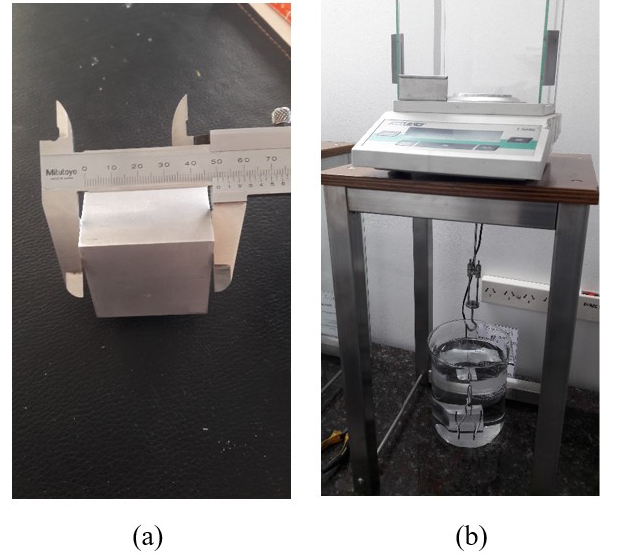
Figure 1. Experimental determination to 0.1% of the mass of an aluminium cube following the new definition of the kilogram trace- able to the Planck constant. The cube volume is obtained by di- mensional measurements (a) , optionally also by hydrostatic weigh- ing (b) . The number of atoms N is calculated taking a precise value of the edge dimension a of the aluminium unit cell. The mass of the cube is then expressed as m c = Nm (Al), being m (Al) the mass of a single aluminium atom, obtained from the quotient h/m atom provided to high accuracy by atom